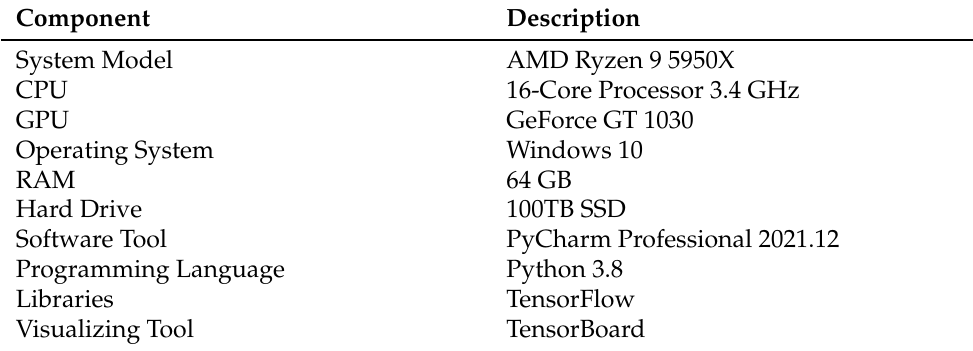
Table 2. Hardware and software